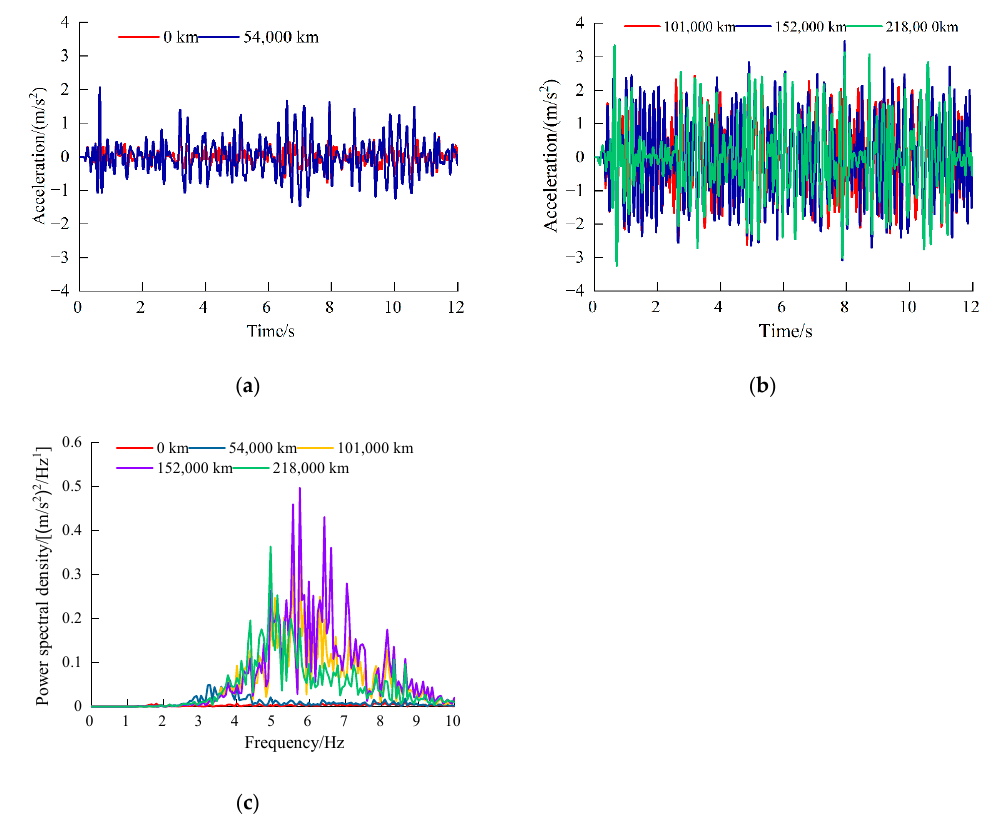
Figure 12. Vibration on bogie frame ends for Line A: ( a ) service distance less than 54,000 km; ( b ) the service distance more than 101,000 km;( c ) frequency domain.